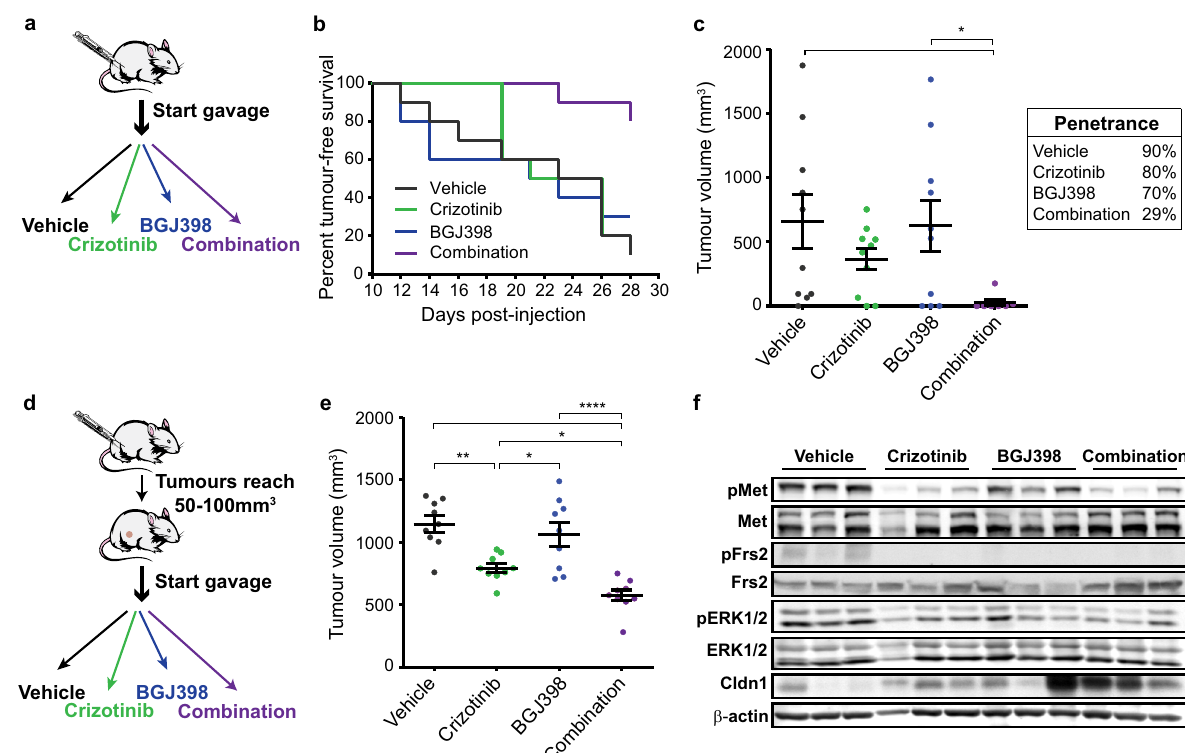
Fig. 5 Co-inhibition of Met and FGFR1 signalling in vivo reduces tumour-initiating potential of MMTV- Met mt ; Trp53 fl / + ; Cre spindloid cells and delays progression of established tumours. a Female athymic mice were injected with A1129 cells in the 4th mammary fad pad and treated daily with vehicle control, Crizotinib alone (50 mg/kg), BGJ398 alone (30 mg/kg), or the two agents in combination by oral gavage. b Kaplan – Meier curves of the percentage of tumour-free A1129-injected mice in the indicated treatment groups. Mice were sacri fi ced after 28 days and their tumours collected. c Tumour volumes on day of sacri fi ce (left) and percent penetrance in each treatment group (right) (vehicle ( n = 10), Crizotinib ( n = 10), BGJ398 ( n = 10), and combination ( n = 7)). d Female athymic mice were injected with A1129 cells in the 4th mammary fat pad and tumours were allowed to reach 50 – 100 mm 3 in volume before randomisation into treatment groups. e Tumour volumes after 11 days of drug treatment ( n = 9). f Tumour lysates were prepared from three mice per treatment group, and western blot analysis was performed for the indicated antibodies. Student ’ s t test; * P ≤ 0.05; ** P ≤ 0.01; **** P ≤ 0.0001. Error bars indicate